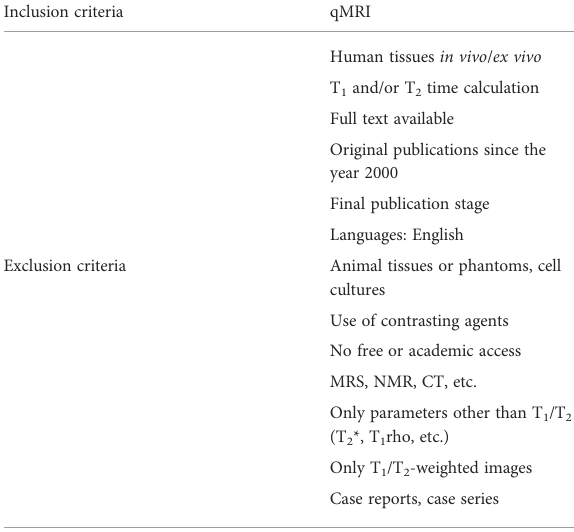
TABLE 7 Review inclusion and exclusion criteria for original